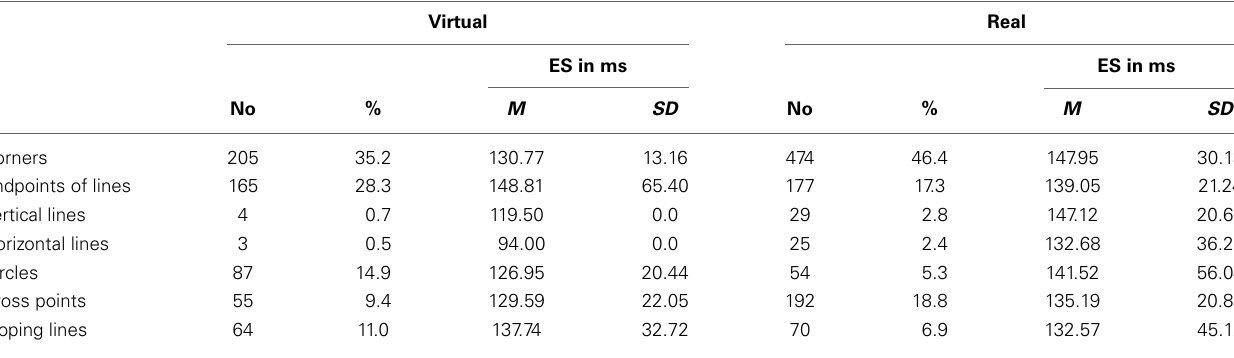
Table 4 | Number (No) of explorative Stops (ES), and mean time of ES in relation to stimulus features for Experiment D (virtual sunken relief) and experiment E (real sunken